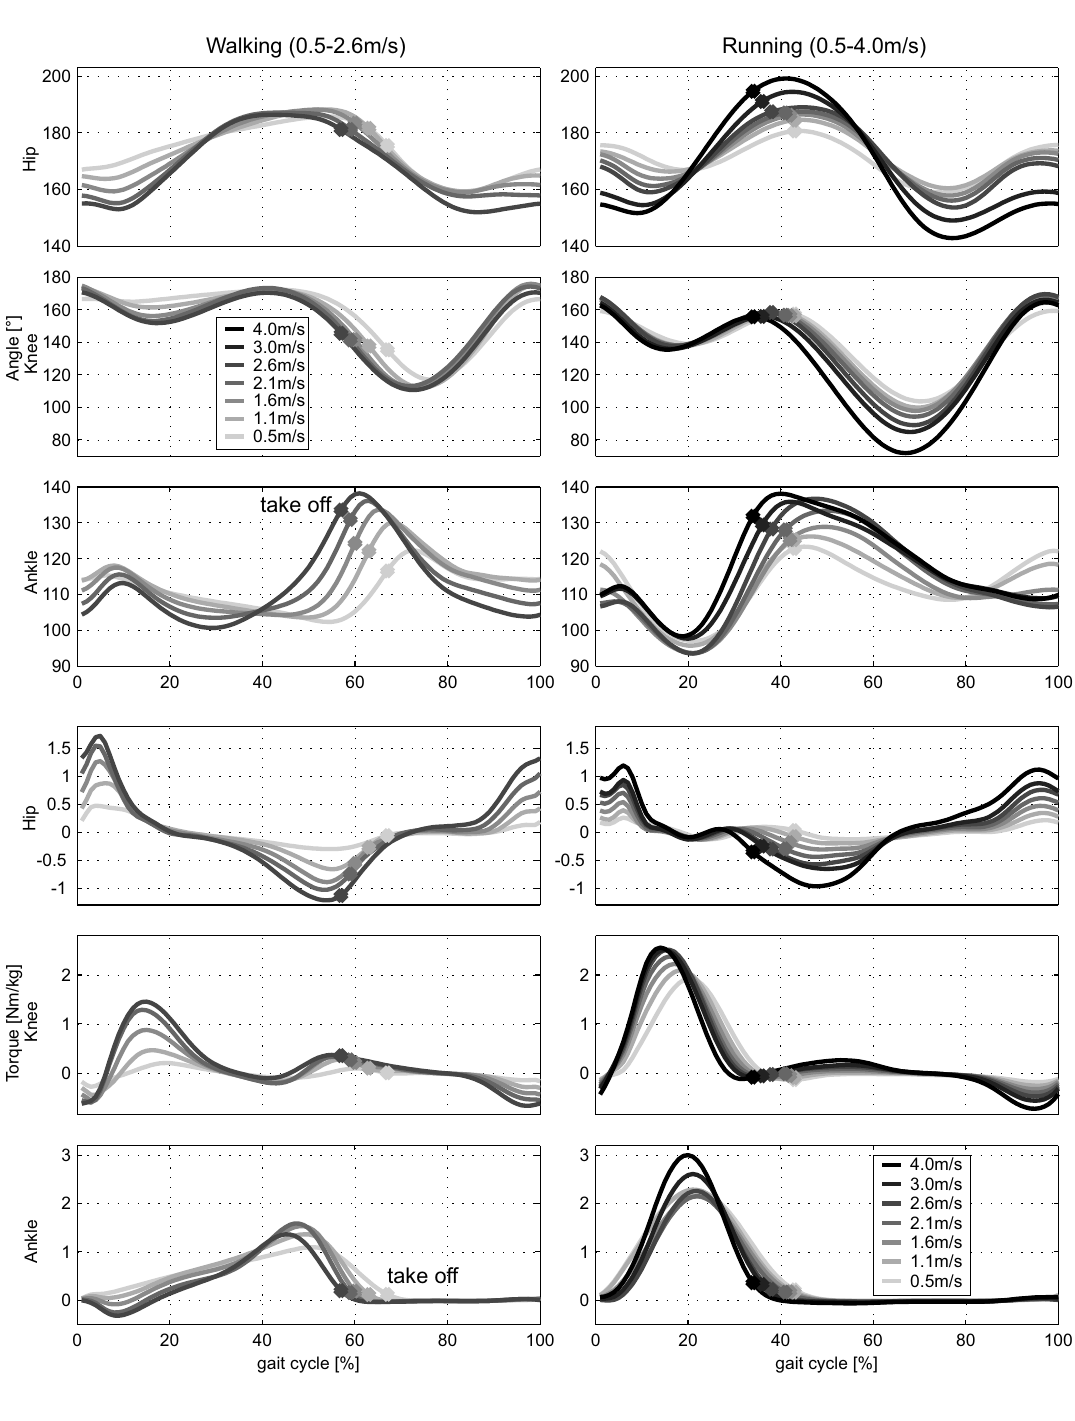
Figure 1. Hip, knee and ankle joint angle and joint torque for a gait cycle of human walking and running (mean of all subjects). Hip angle was calculated between the seventh cervical vertebra, trochanter major and a assumed rotational point at the knee (2 cm proximal to the lateral joint space on the lateral femoral condyle). The knee angle was calculated as the angle between the line connecting the greater trochanter major and the rotational knee point and the line connecting the rotational knee point and the lateral malleolus. The ankle angle was calculated by the rotational point of the knee, the lateral malleolus and the fifth metatarsophalangeal joint of the foot. Light grey lines represent slower speeds starting at 0.5 m/s. The black line represents maximum speed of 4 m/s (only